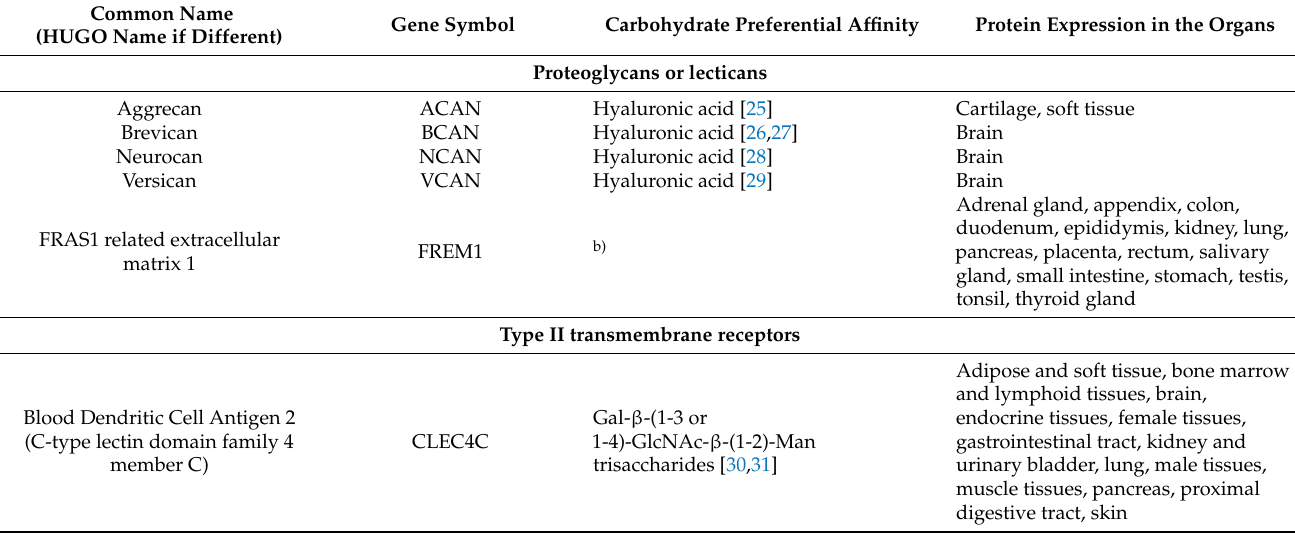
Table 1. C-type superfamily, their carbohydrate ligands and protein expression in human organs. Common Name (HUGO Name if